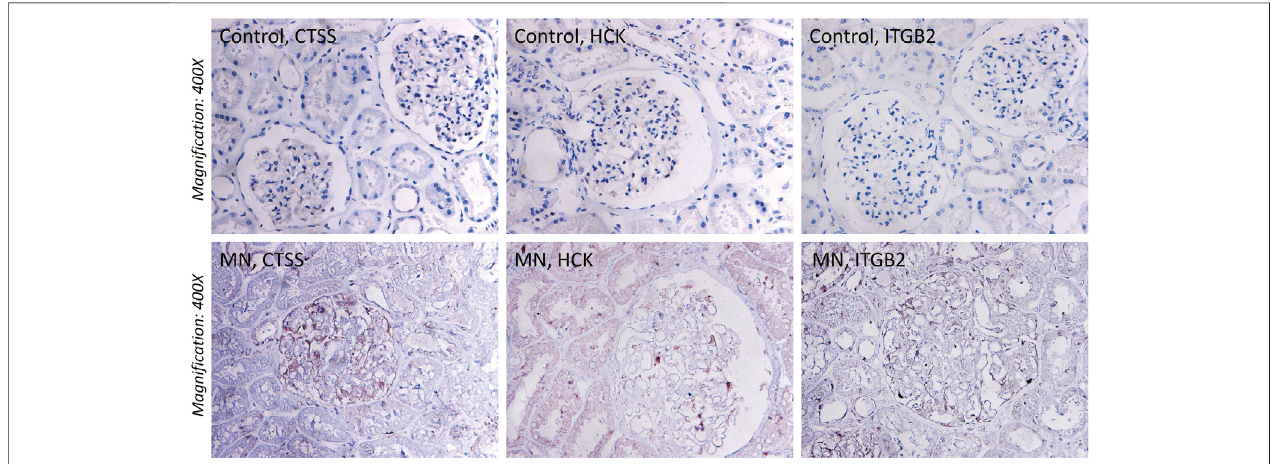
FIGURE 6 | Immunohistochemistry (IHC) staining of CTSS, HCK, and ITGB2 in MN tissues and normal renal tissues. The expression of CTSS, HCK, and ITGB2 protein in MN tissues was higher than that in control group.